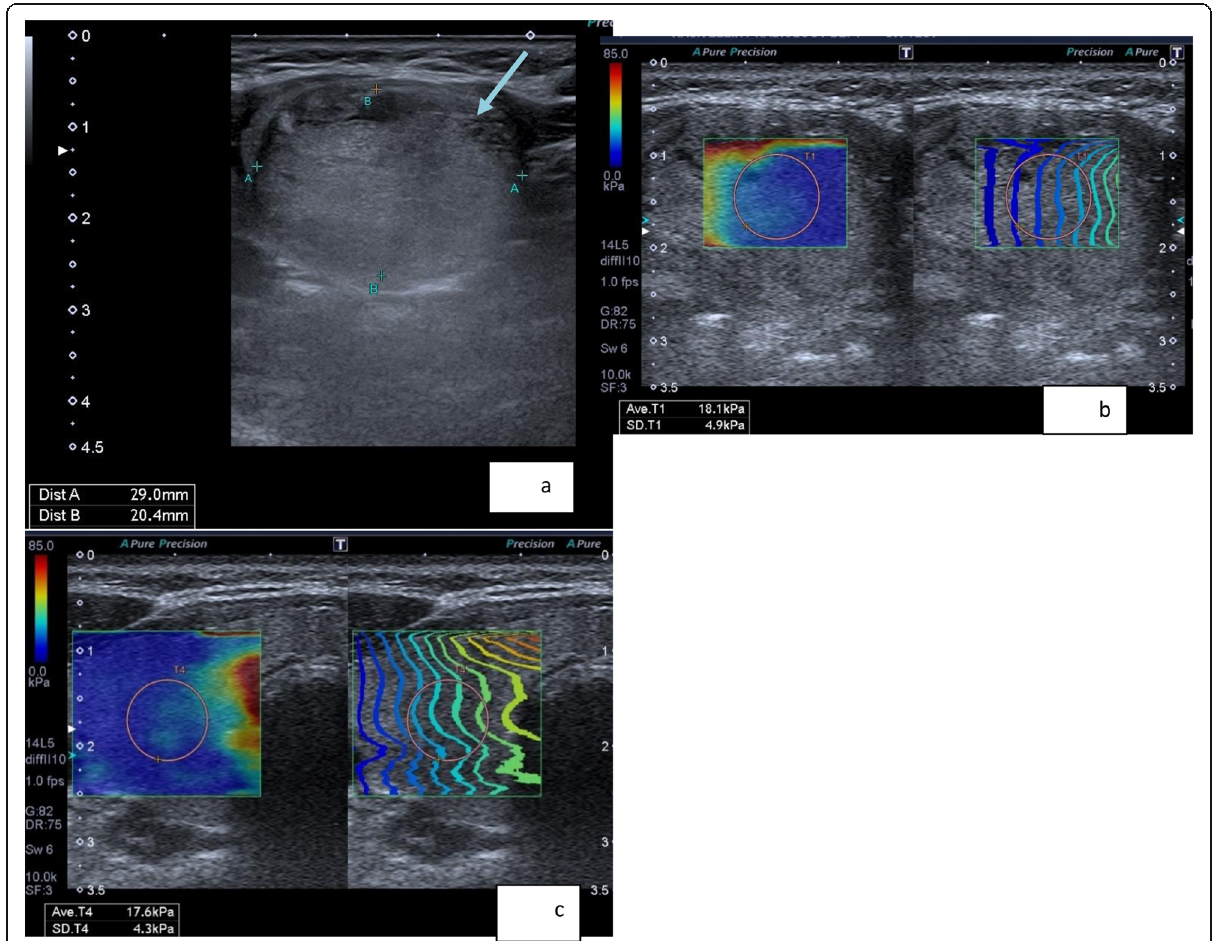
Fig. 3 Ultrasound images for a 57-year-old female patient presented with a neck swelling. a Axial ultrasound B-mode image is showing a left solid isoechoic thyroid nodule (TI-RADS 4) (arrow). b Axial SWE of the nodule ( E mean = 12.1 kPa and ER = 2.0). c Axial SWE of the normal right thyroid parenchyma; the FNAC revealed a nodular hyperplasia (Bethesda 2); thus, SWE EIs were also concordant with the cytological